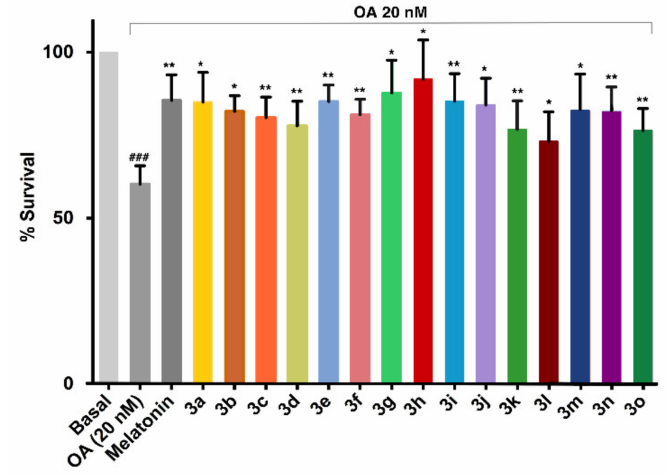
Figure 6. Survival (%) of SH-SY5Y cells following a toxic insult induced by okadaic acid (OA) (20 nM) in the presence of compounds 3a – 3o (1 µ M), with melatonin as a positive control. Data are expressed as mean ± SEM of three experiments by triplicate. One-way ANOVA Newman–Keuls post-test: ### p < 0.001; compared to basal; * p < 0.05, ** p < 0.01, compared to the toxic. Numerical data are given in the Supplementary Materials (Table